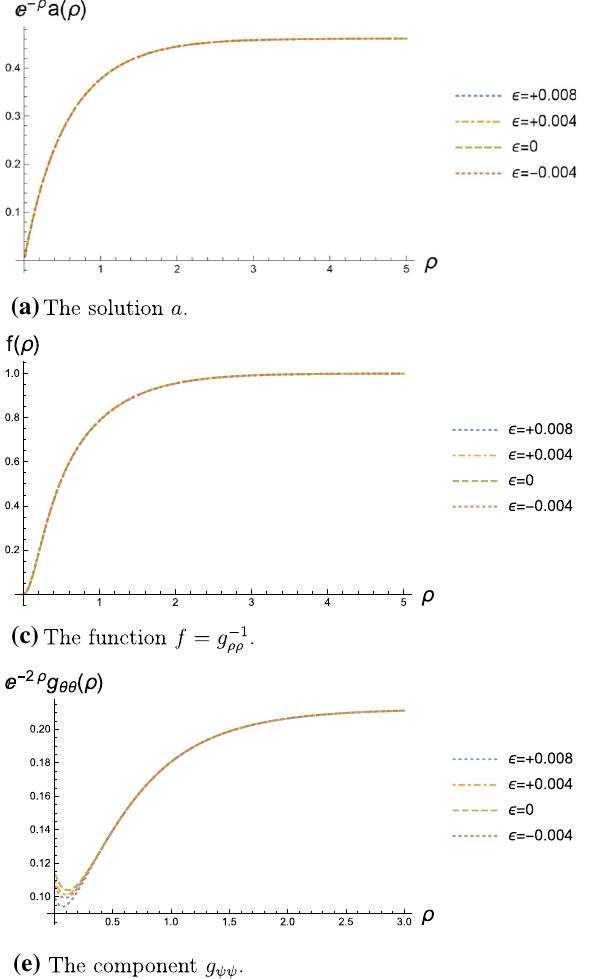
Fig. 2 Relevant functions and metric components of our solution for α = 0 . 84, ξ = − 1 and different values of (cid:14) , reported in the label. Each 4 function is rescaled by its asymptotic behavior at large ρ . We empha-